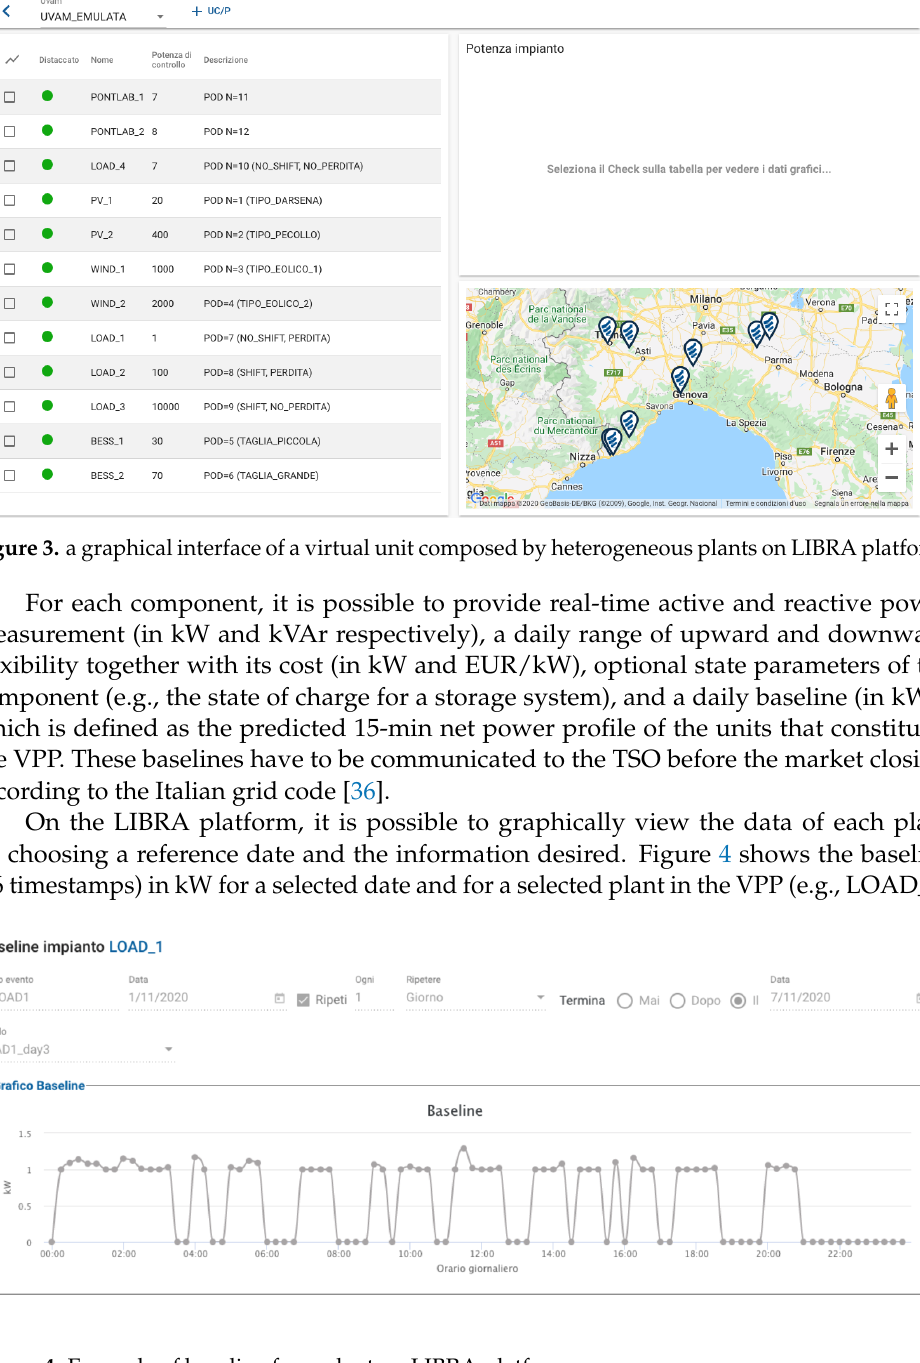
Figure 4. Example of baseline for a plant on LIBRA